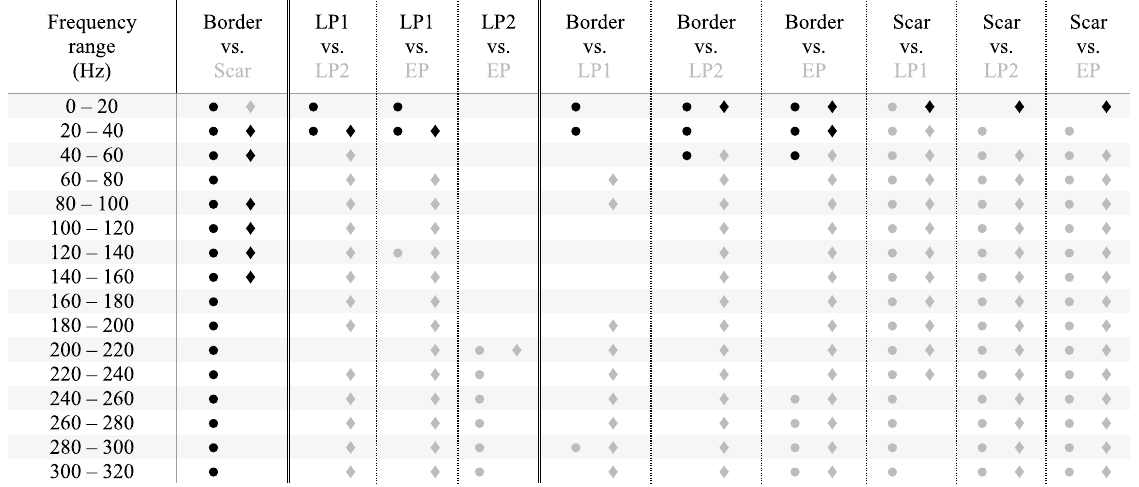
Table 1. Statistically significant differences (p < 0.025) amongst the different pair-wise comparisons obtained via PSD analysis considering absolute ( ● ) and relative ( ♦ ) power contents in the different spectral sub-bands by the post hoc Conover’s non-parametric multiple comparison statistical test. Wherever statistically significant differences could not be found, no symbol was reported. The colour of each symbol (black or grey) is associated with the EGM type, indicated in the heading line of that column with the same colour, exhibiting the highest median power content in that specific comparison (e.g., in the first column, which is related to the comparison between Border and Scar, black symbols are reported whenever an higher contribution of the border EGMs was detected, whereas grey symbols are present in case of significantly greater contribution of scar